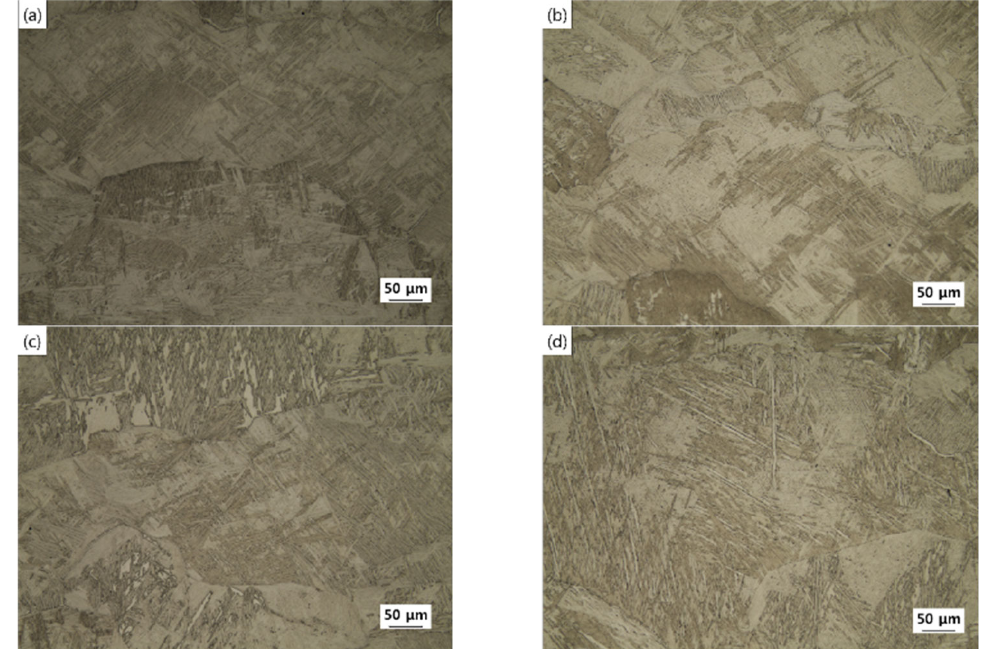
Figure 14. Microstructures of the cross-sectioned areas according to each condition after high- temperature compression of Ti-6Al-4V alloy; ( a , c ) 1050 ◦ C, 1 × 10 − 2 /s, ( b , d ) 1100 ◦ C, 1 × 10 − 2 /s; ( a , b ) Dead Zone, ( c , d ) Severe Plastic Deformation